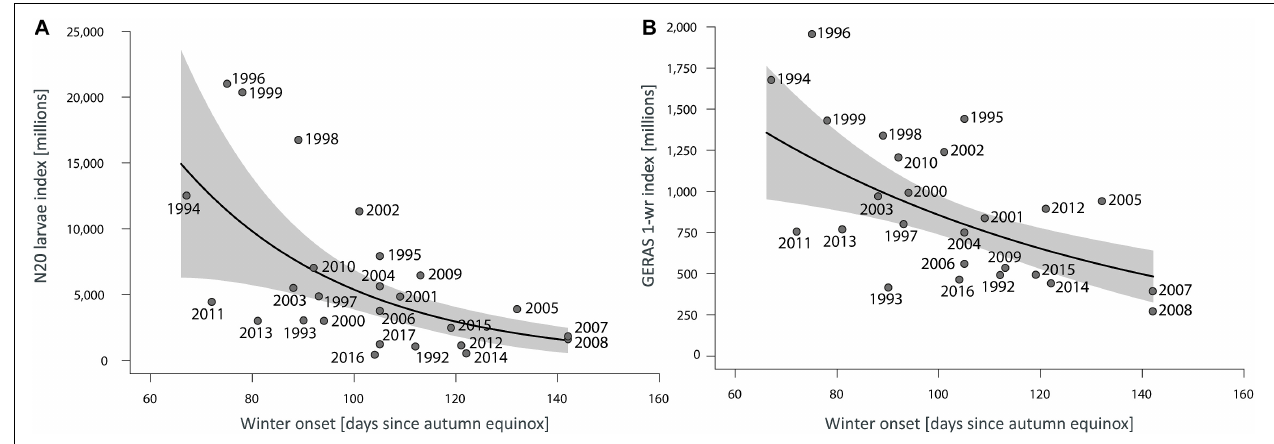
FIGURE 6 | Predicted effect of winter onset (lines) and associated 95% CI (shadows) by the best candidate models on (A) the N20 larvae index in the nursery area, and (B) abundance of 1-year-old juveniles (GERAS 1-wr) in the western Baltic Sea. Points represent the annual estimates of the indices related to empirical values of the winter onset descriptor. In (B) the index is lagged 1 year in relation to the